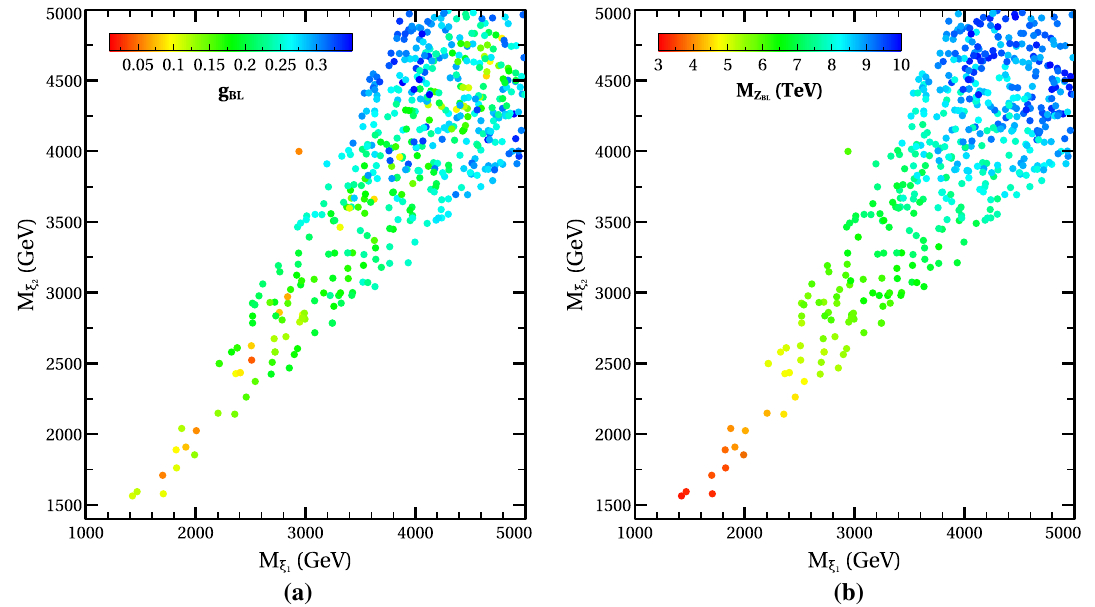
Fig. 6 DM parameter in terms of DM masses space satisfying all relevant constraints. The colour coding is used to denote g BL , M Z right panels respectively